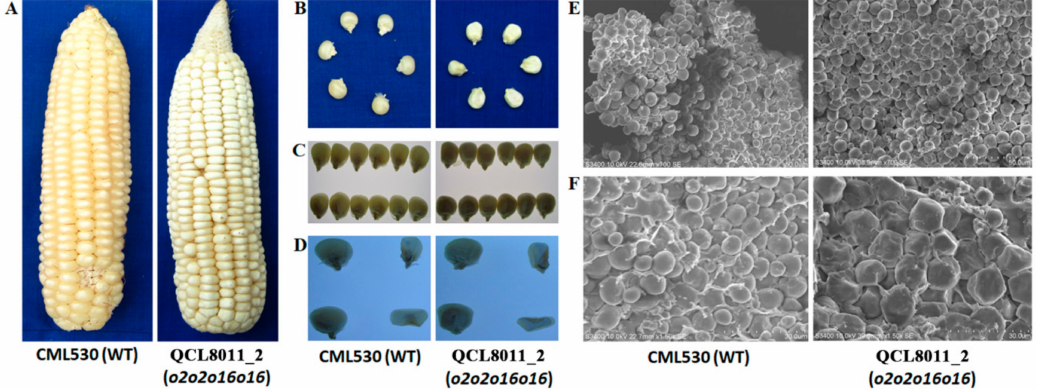
Figure 1. Phenotypic features of CML530 and QCL8011_2. ( A ) Photographs of intact ears taken under normal light. ( B ) Photographs of mature kernels taken under normal light. ( C ) Light transmission of mature kernels on a light box. ( D ) Cross-sections of mature kernels on a light box. ( E ) Scanning electron micrograph for endosperms of QCL8011_2 and CML530 at 700 × magnification. ( F ) Scanning electron micrograph for endosperms of QCL8011_2 and CML530 at 1500 ×